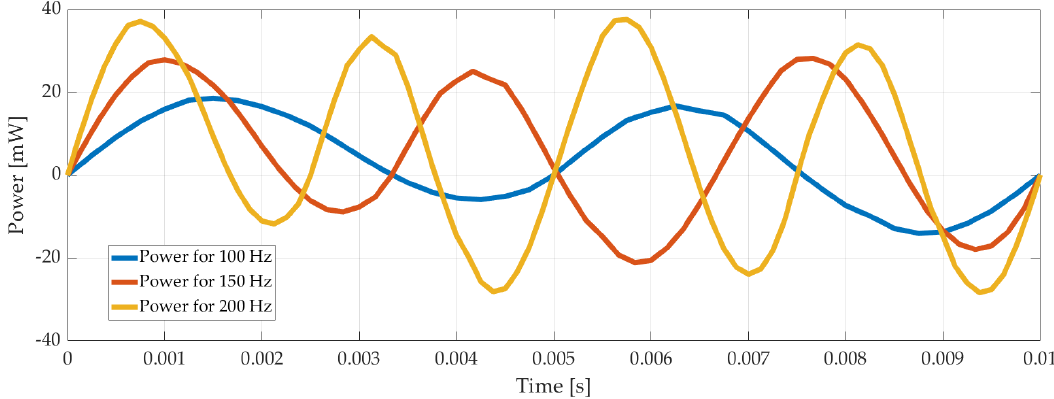
Figure 6. Power consumption of the pump with time for 100 Vp-p, 100 Hz, 150 Hz, and 200 Hz.